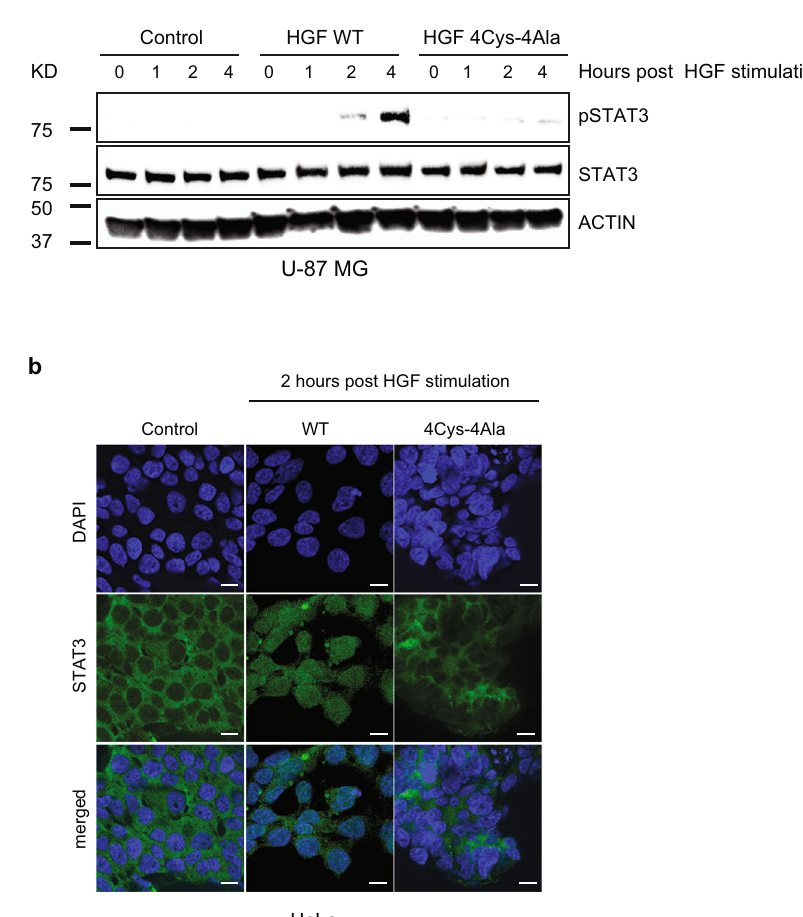
Fig. 3 Core cysteines in HGF PAN domain is essential for STAT3 phosphorylation and nuclear translocation. a Impaired HGF PAN domain is unable to initiate STAT3 phosphorylation. U-87 MG cells were treated with HGF WT and HGF 4Cys-4Ala where indicated for 1, 2, and 4 h. Cell extracts were prepared and probed for phosphor-STAT3 and total STAT3. b STAT3 nuclear localization is suppressed by PAN mutant HGF. HeLa cells were stimulated with HGF WT and HGF 4Cys-4Ala as indicated. Cells were fi xed and STAT3 was immunostained with a STAT3-speci fi c antibody. The localization of STAT3 (green) and 4,6-diamidino-2-phenylindole (DAPI) (blue) in U-87 MG cells. Images were visualized using Zeiss LSM 710 at 63× objective. Scale bars represent 20 μ m. The images shown are representative of three independent biological replicates (an average of 100 cells were observed for each condition